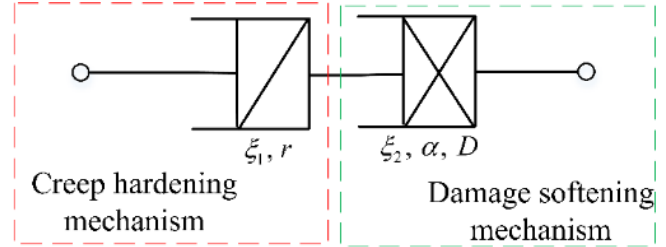
Figure 3. Schematic of fractional creep damage